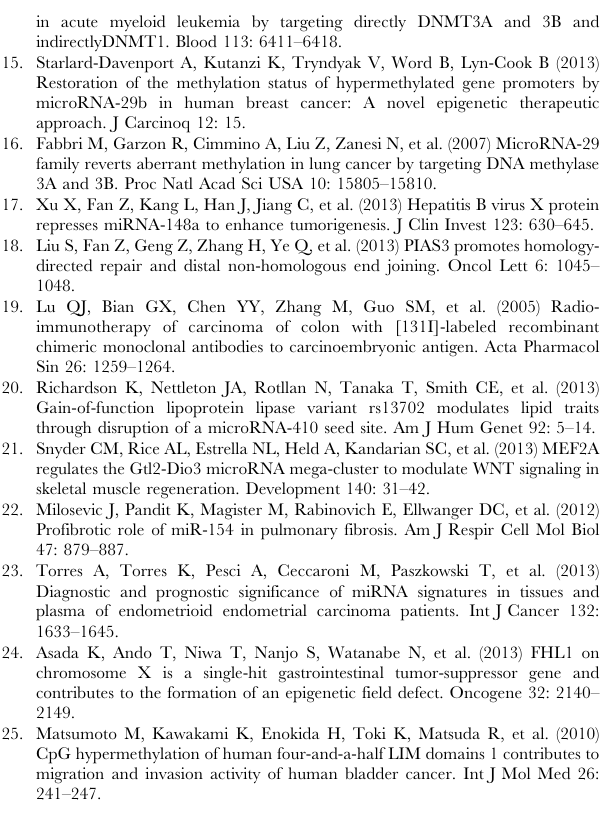
blotting to verify the three cell lines (top 2 panels). Cell growth assays of the three cell lines were analyzed (bottom panel). Data shown are mean 6 sd of triplicate measurements. * P , 0.05 versus control on day 3. ** P , 0.01 versus control on day 4. (B) Cell viability was assessed using migration transwell assays at the indicated times. Scale bar, 100 m m. * P , 0.05 versus control. (C) Figure S6 Expression of FHL1, miR-410 and DNMT3A in mouse tumors and surgical human liver and colorec- tal cancer specimens. (A) FHL1, miR-410 and DNMT3A expression level were determined in HepG2 tumors harvested from in vivo animal experiments ( n = 3). * P , 0.05 versus control. ** P , 0.01 versus control. (B) Decreased expression of FHL1, and increased expression of miR-410 and DNMT3A in digest tract tumors (colorectal and liver cancers) ( n =55) compared with the paracancerous tissues analyzed by qRT–PCR. A horizontal line represents the mean expression level in each group. * P , 0.05;